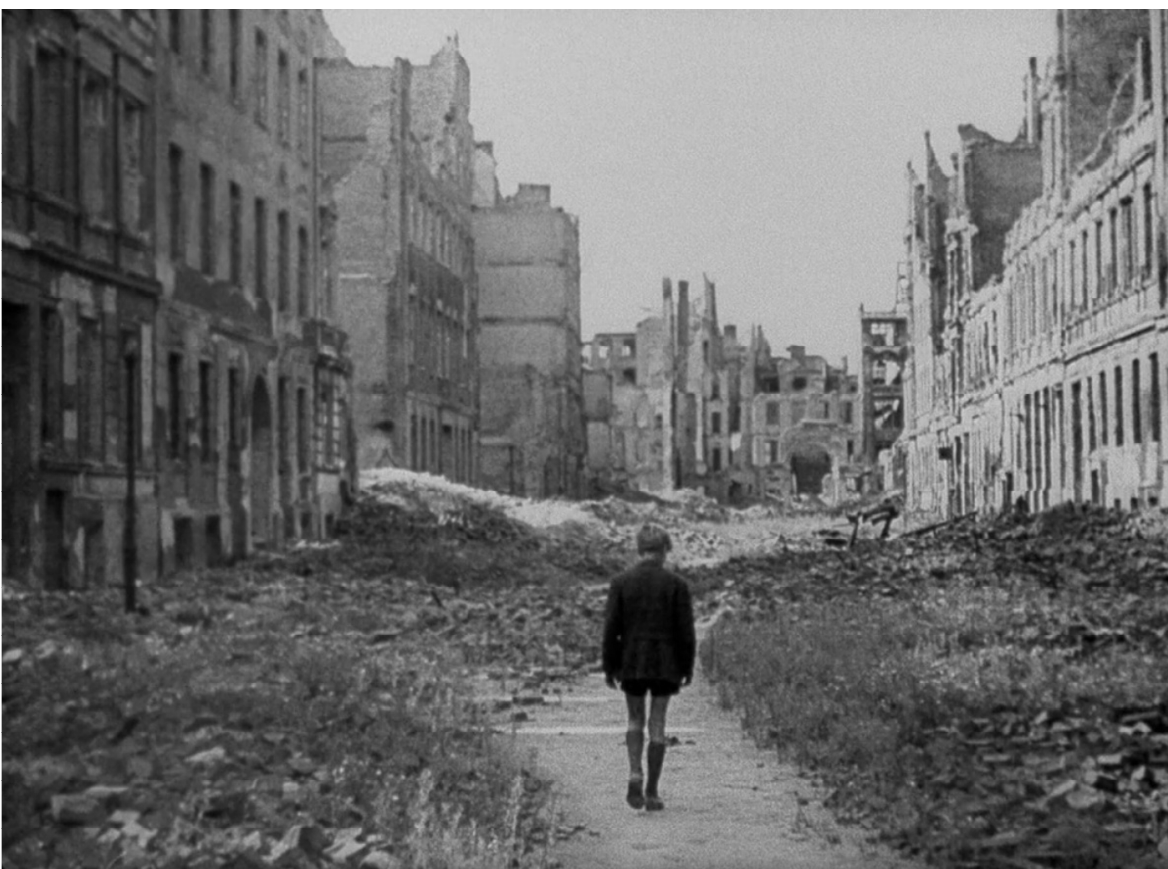
Figure 2. Ruderals surround Edmund , film still from Germania, Anno Zero (Roberto Rossellini, 1948).